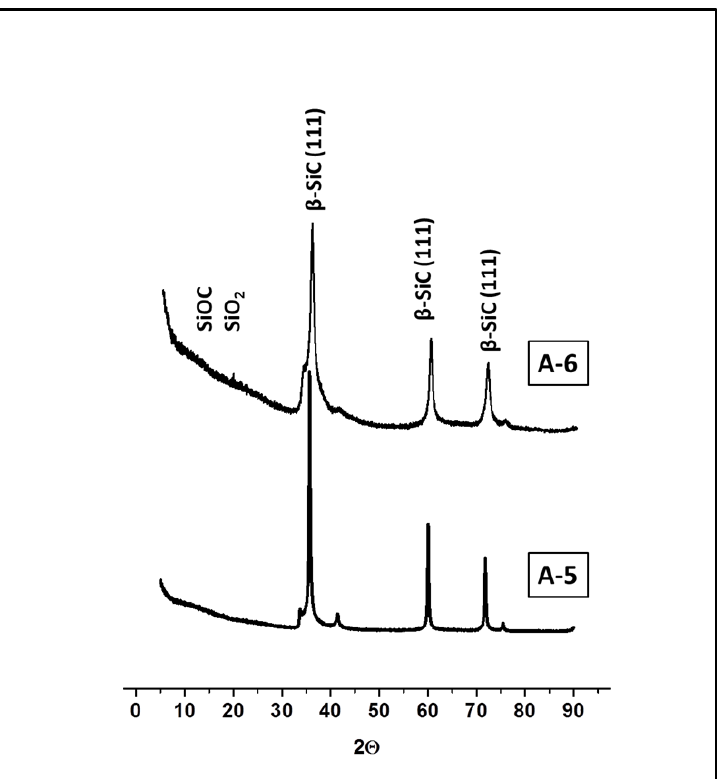
Figure 7. X-ray diffraction traces for SiC/C f microspheres obtained by cross-linking with DVB.